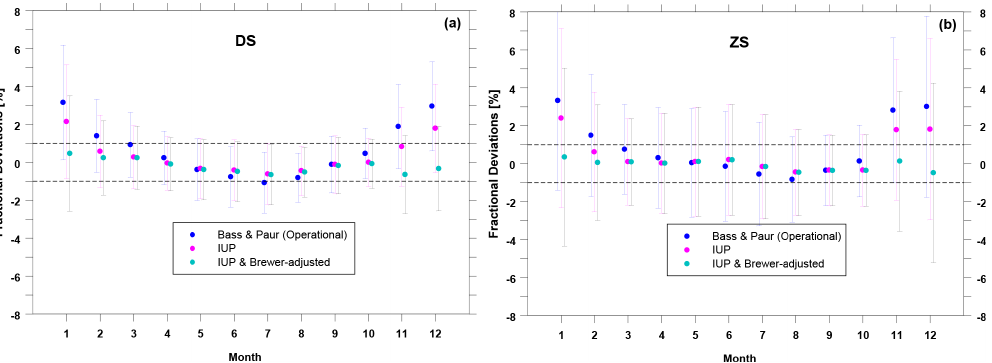
Figure 8. The monthly means of the Brewer–Dobson differences for the operational data (Bass–Paur O 3 AC at fixed temperature) after application of the correction, according to Eq. (2), for the dependence of O 3 AC on temperature based on IUP measurements and after adjustment of the Dobson TCO 3 to the Brewer TCO 3 equivalent by Eq. (3) accounting for the stray light effect differences between the spectrophotometers. The results are for DS measurements (a) and ZS measurements (b) . Bar denotes the range: mean ± standard